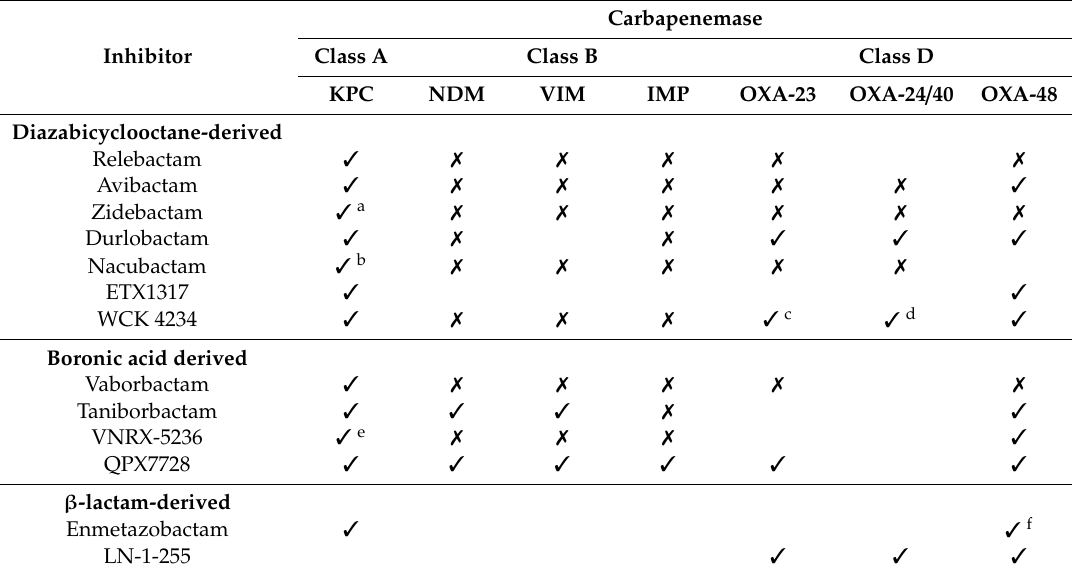
Table 4. Inhibition of major carbapenemases by new carbapenemase inhibitors.